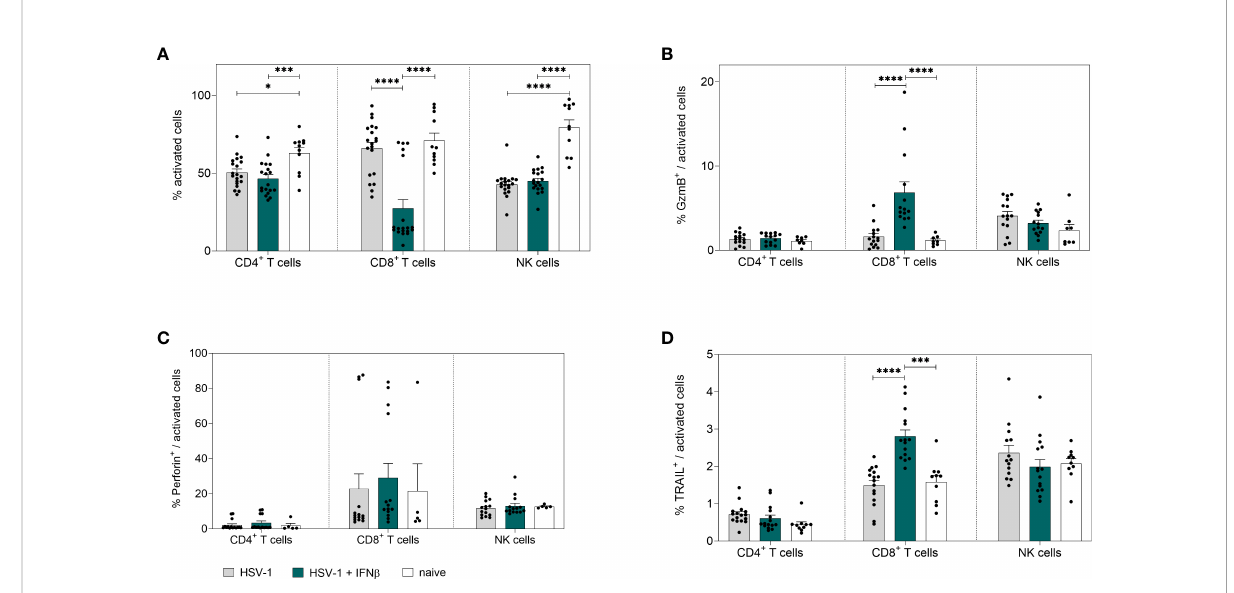
FIGURE 5 Peripheral immune responses in the spleen on day 4 post HSV-1 infection. Female C57BL/6 mice were infected with 1×10 7 TCID 50 of HSV-1 F for four days or left uninfected (naive control). Mice were treated with 8000 U of murine IFN b for two consecutive days starting on day 2 p.i. or left untreated (HSV-1). On day 4 p.i ., splenic lymphocytes were isolated from dissected spleens. For fl ow cytometric analysis, isolated cells were stained for respective cell surface and intracellular markers. (A) Frequencies of activated CD4 + T cells, CD8 + T cells and NK cells as well